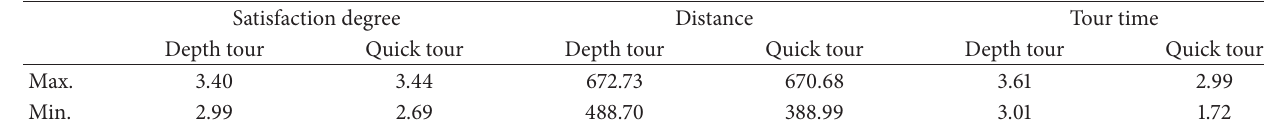
Figure 12: Suggested depth tour route and quick route. Table 2: Parameter of depth tour and quick tour.